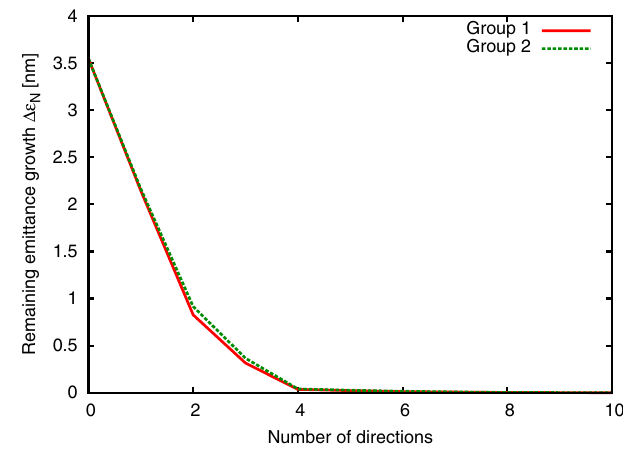
FIG. 12. Emittance reduction of 50 ILC seeds along the prin- cipal directions of the group of seeds itself (group 1) compared to along the principal directions obtained from a separate set of seeds (group